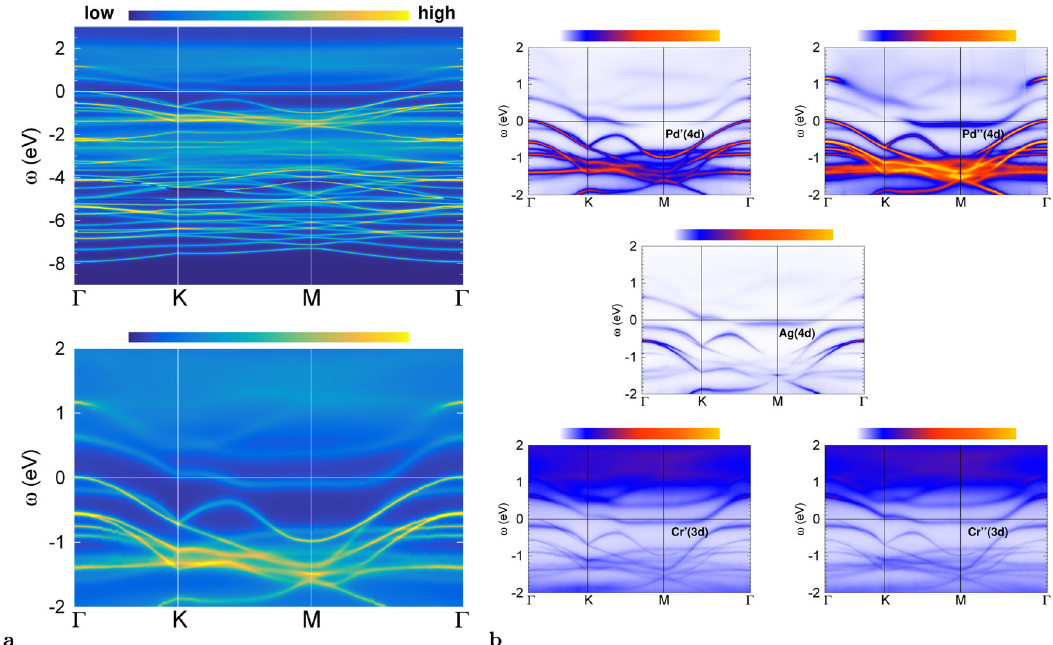
Fig. 11 Interacting spectral information for effective-kagomé (Pd,Ag)CrO 2 from DFT + DMFT. a Spectral function in (top) larger and (bottom) smaller energy window. b Orbital-site content ('fatbands'), from top to bottom: both symmetry-inequivalent Pd(4 d ), i.e., Pd'(4 d ) and Pd''(4 d ), Ag(4 d ) as well as both symmetry-inequivalent Cr(3 d ), i.e., Cr'(3 d ) and Cr''(3 d ) (see text). All data for T = 193